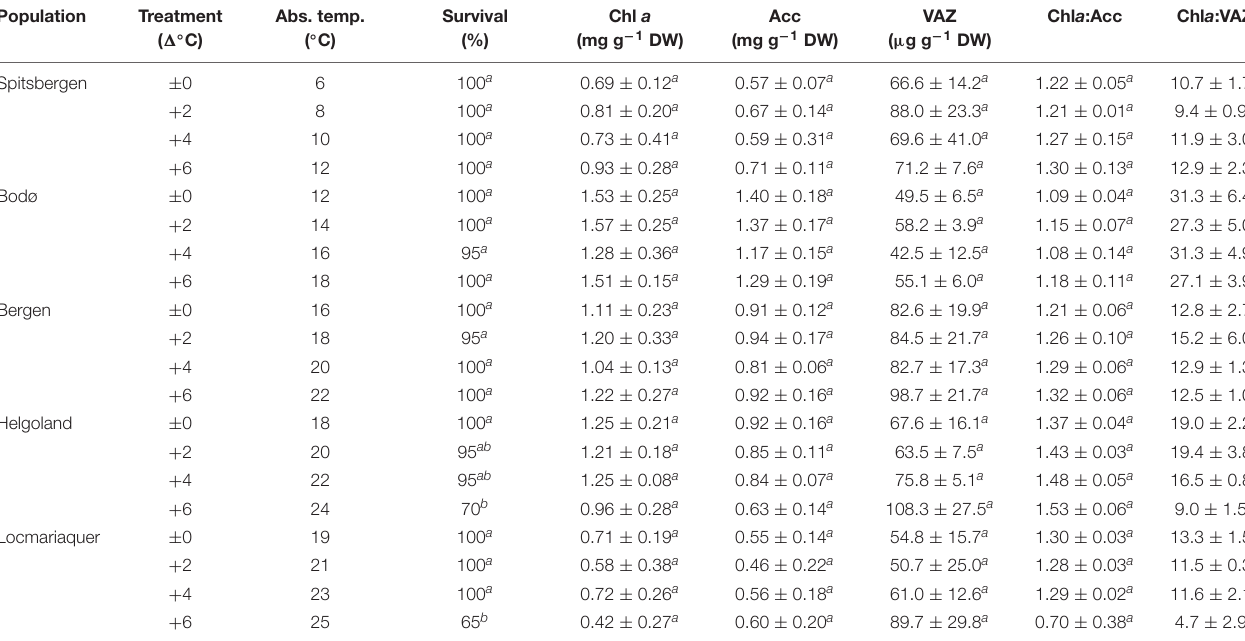
TABLE 2 | Survival, chlorophyll a (Chl a ), pool-size of accessory pigments (Acc) and pool-size of xanthophylls (VAZ), Chl a :Acc ratio and Chl a :VAZ ratio of S. latissima across latitudes in Europe after the temperature-amplitude experiment. Population Treatment ( (cid:49) ◦ C)